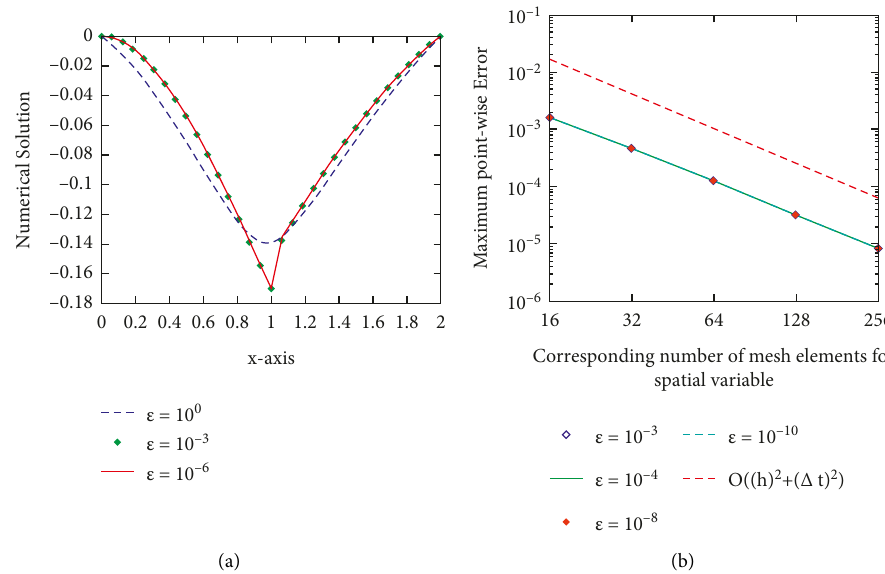
Figure 3: One dimensional plot and log-log plot for Example 1 (a) Numerical solution at t � 2, when N � 32, (b) Log-log